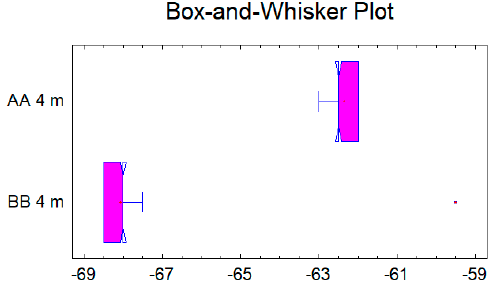
Figure 7. Box-and-whisker plot for reading distance 4 m.